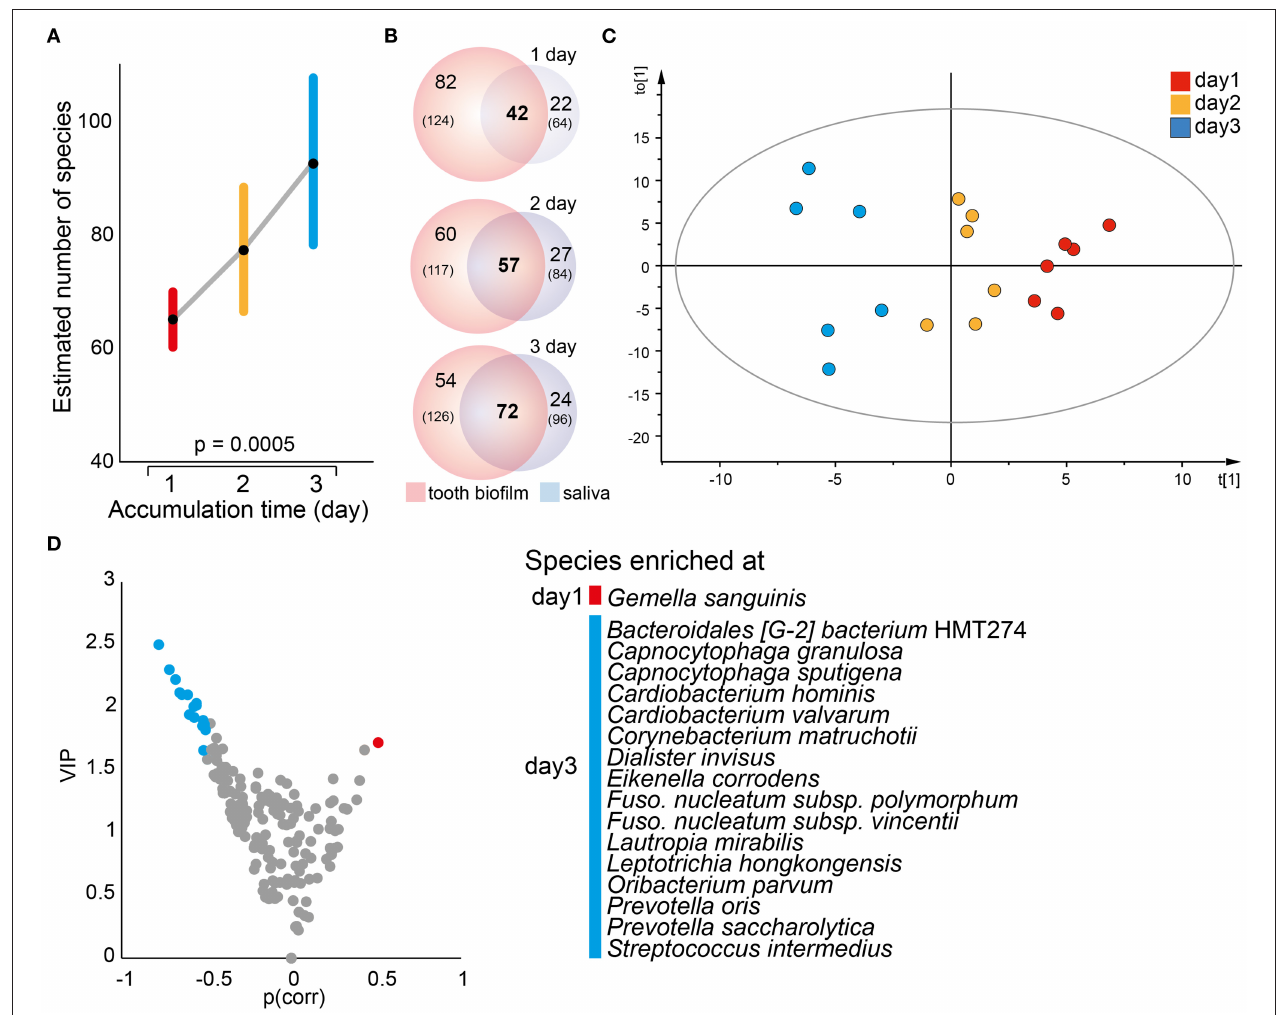
FIGURE 5 | Temporal trends in saliva microbiota composition. (A) A mixed linear model of the estimated number of species in saliva samples at each accumulation time. Data are shown as the estimated marginal mean with 95% CIs. (B) Venn diagrams illustrating the total number of species detected ( n ) in the pooled tooth biofilm and saliva samples, respectively, whereas numbers in bold represent the species detected in both sample types by increasing accumulation time. (C) Multivariate OPLS-DA modeling illustrates a distinct separation of the saliva microbiota composition by discrimination component t [1] when increasing the accumulation time from 1 to 2–3 days. (D) Volcano plot of p {PLS correlation coefficient [ p (corr) > 0.5] vs. VIP > 1.5} highlights the most influential bacterial species most in separation by accumulation